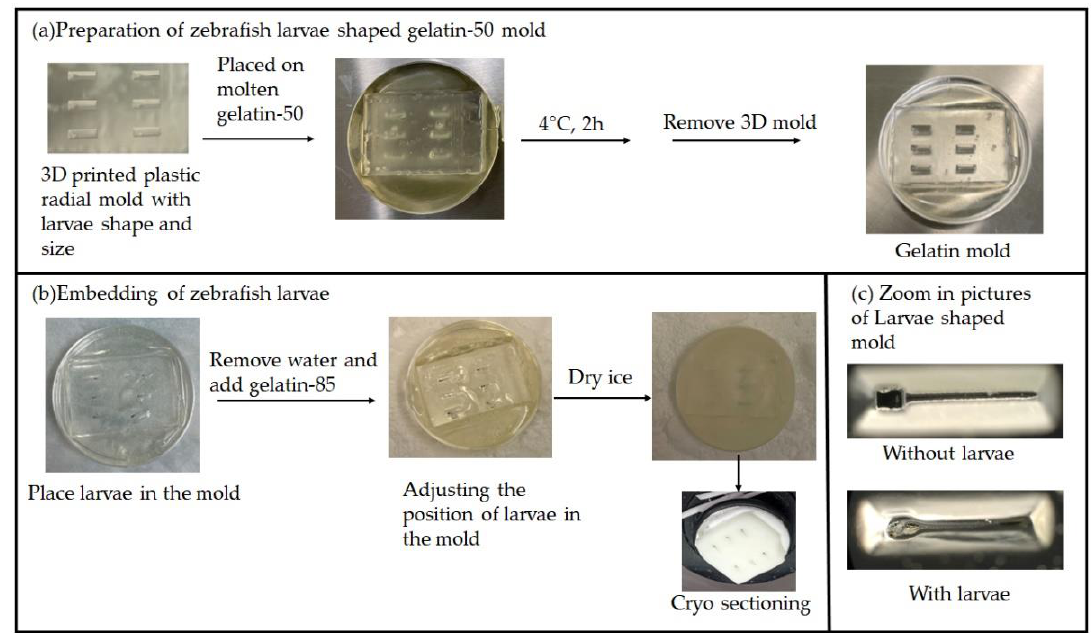
Figure 2. ( a ) Preparation of larvae-shaped gelatin-50 mold with 3D-printed plastic mold; ( b ) embed- ding of larvae in gelatin using gelatin-50 mold and gelatin-85; ( c ) zoom in pictures of larvae-shaped mold with/without larvae.